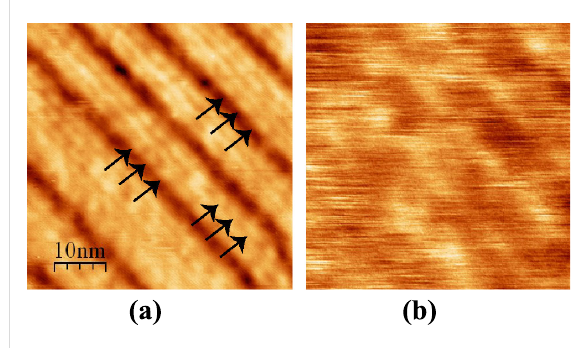
Figure 8: High resolution (a) topographic and (b) Kelvin image of an MLv domain. A = 2 nm, Δ f = − 20 Hz. The arrows in (a) point to the ~4 nm modulation.